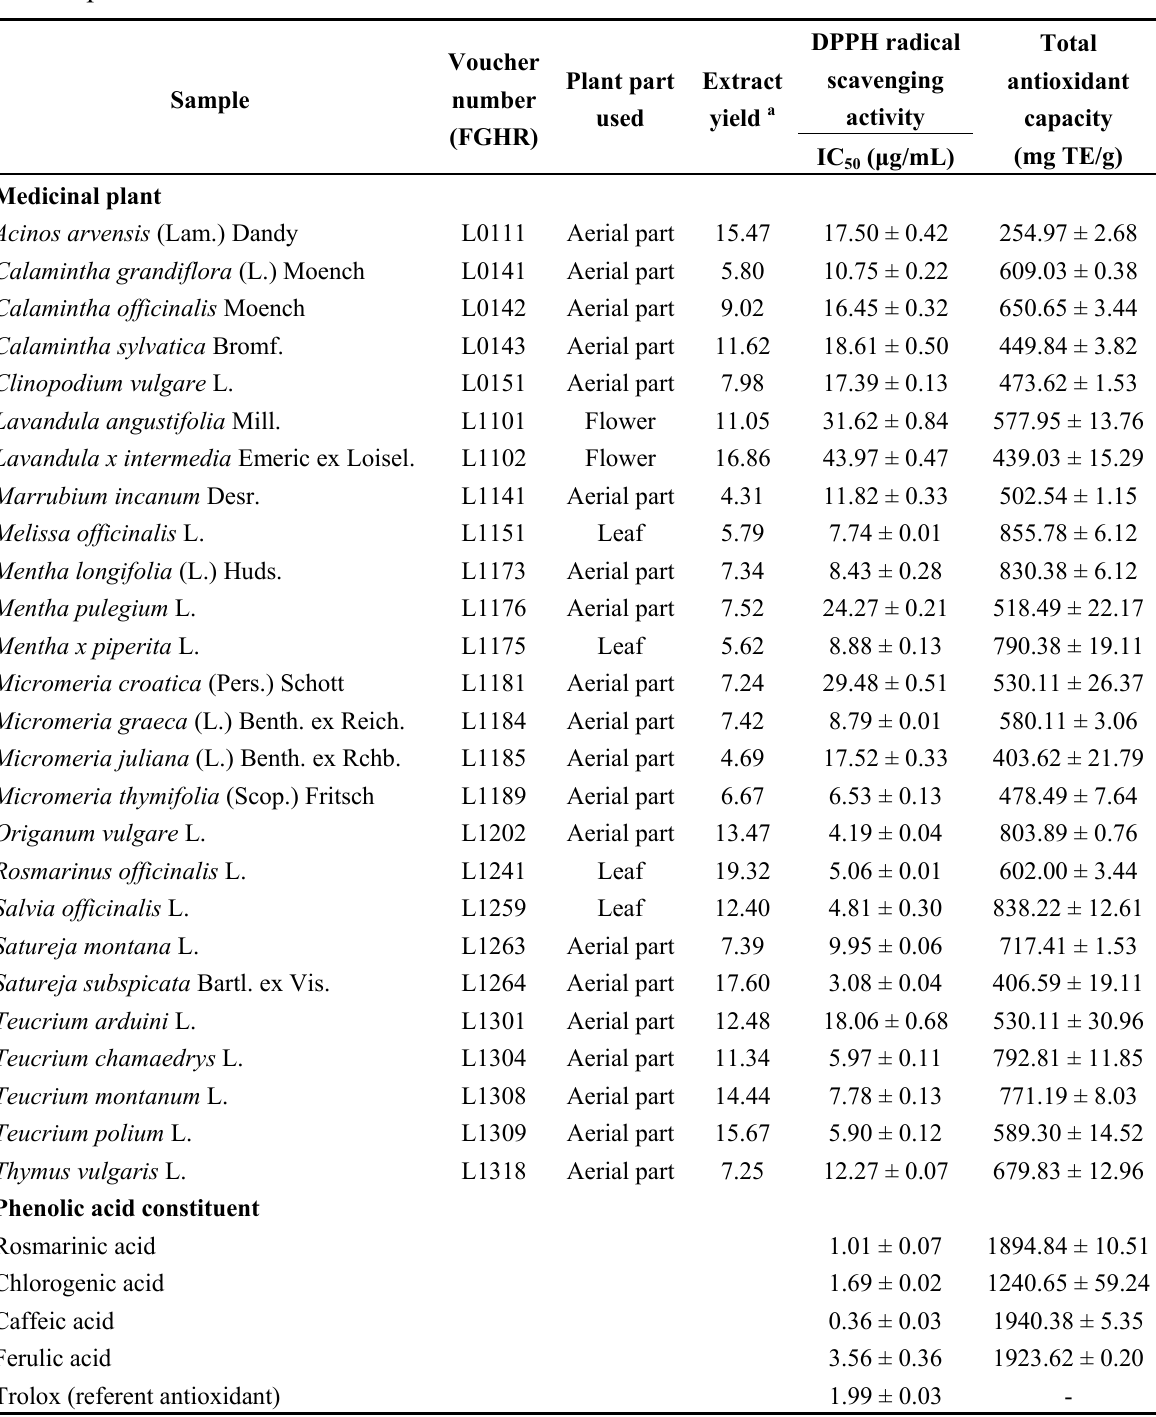
Table 1. Antioxidant activities of the ethanolic extracts of selected Lamiaceae species and their phenolic acid